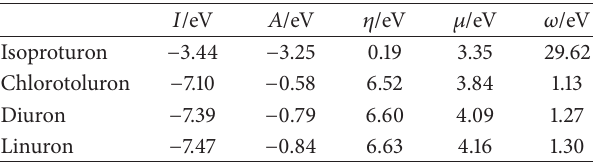
Table 2: Global reactivity descriptors for isoproturon, chloro- toluron, diuron, and linuron at the MP2/6-311++G(2d,2p) level of theory, in the aqueous